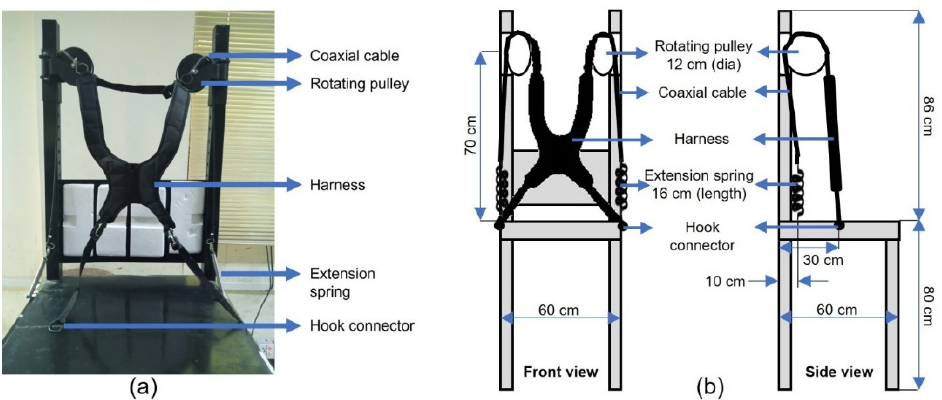
Figure 1. The chair-mounted passive trunk orthosis (CMPTO). ( a ) CMPTO photograph as it is mounted on experimental chair; ( b ) CMPTO schematics for front view (left) and side view